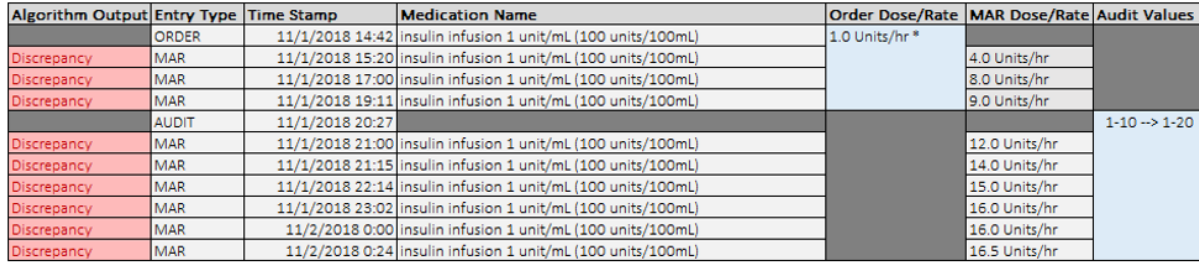
Figure 5. Example of a dosing range order interpretation issue by the algorithm. In this example, orders placed with dosing ranges are not interpreted correctly by the system in place to detect medical administration discrepancies. The algorithms, in their current state, do not expect a dosing range and mark the MAR as a discrepancy if the value doesn’t match the first value in the order dose range. Subsequent titrations that would fall within the acceptable range of the order are erroneously identified as discrepancies by the algorithm. *The Order Dose/Rate in this figure represents the value that the algorithm parses from the original order. In the instance of orders being placed with a dose range (ie, 1-10 Units/hr), the algorithms only parse and use the first value of the dose range. MAR: medication administration record.